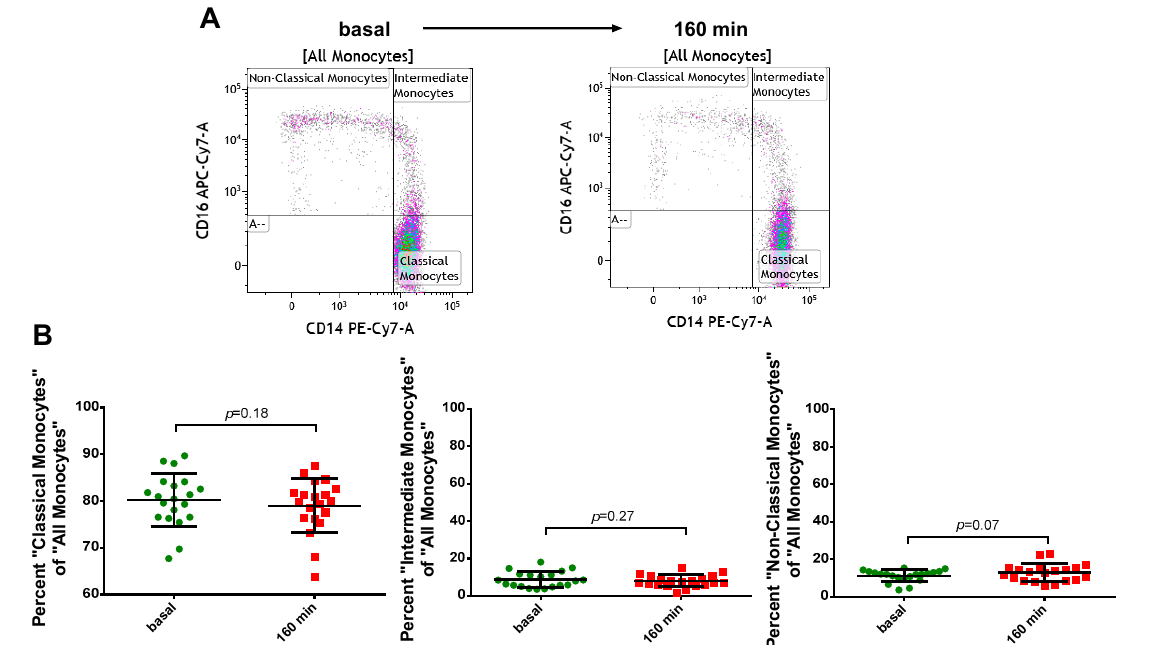
Figure 5. Monocytes keep their antigen classification after PFOB-NE ingestion. Whole blood samples were analyzed before and after exposure to PFOB-NE for 160 min. The percentage of different monocyte subsets of all monocytes was classified using flow cytometry. ( A ) Representative example and ( B ) quantitative analysis for monocyte subset classification.